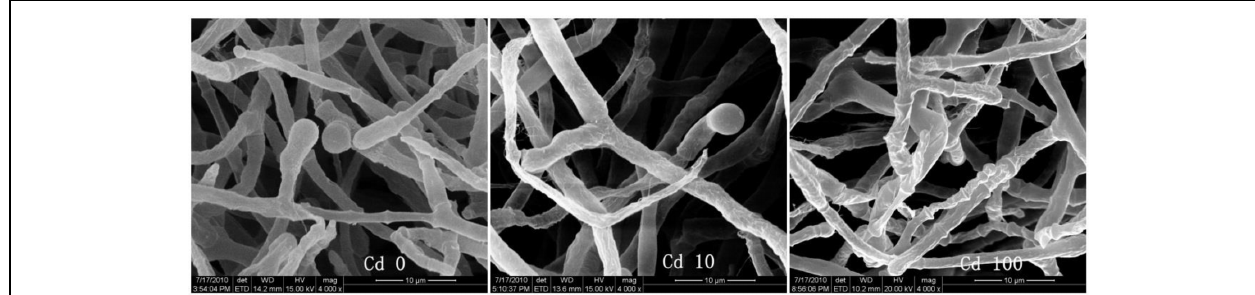
FIGURE 3 | Effect of Cd on the morphology of T. reesei FS10-C.